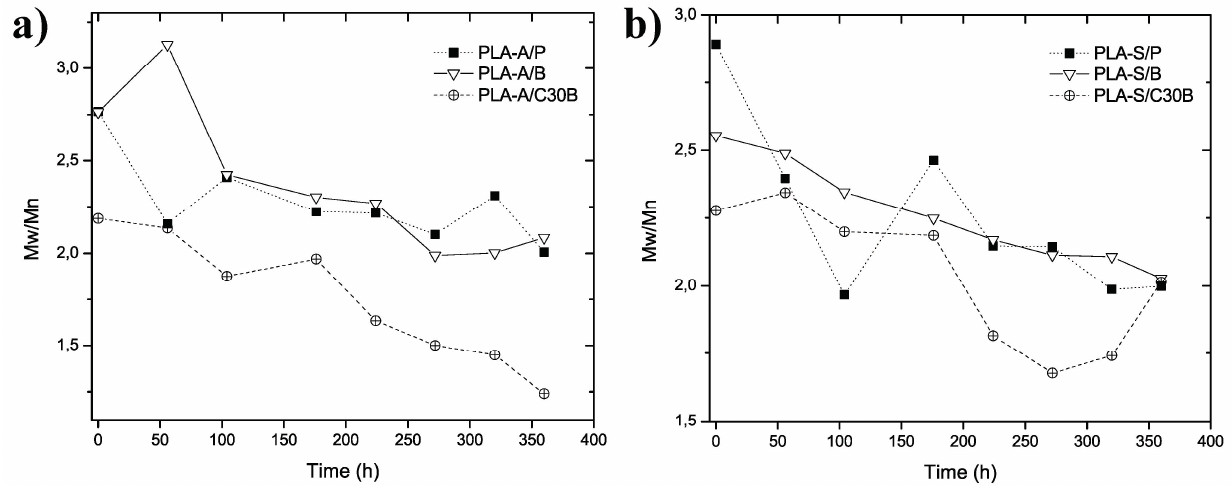
Figure 6. Polydispersity index of ( a ) amorphous and ( b ) semicrystalline PLA as exposure time to artificial weathering was